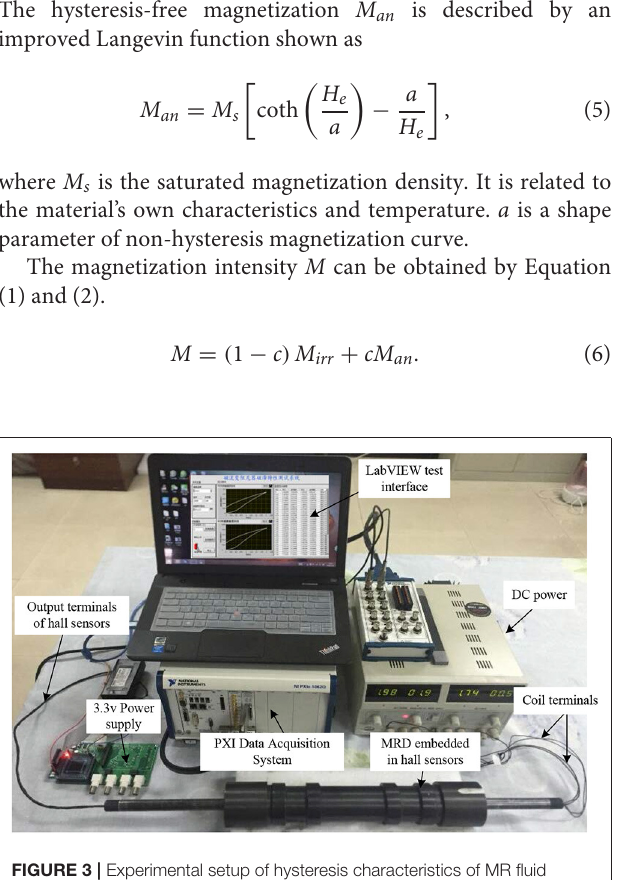
FIGURE 3 | Experimental setup of hysteresis characteristics of MR fluid damper.